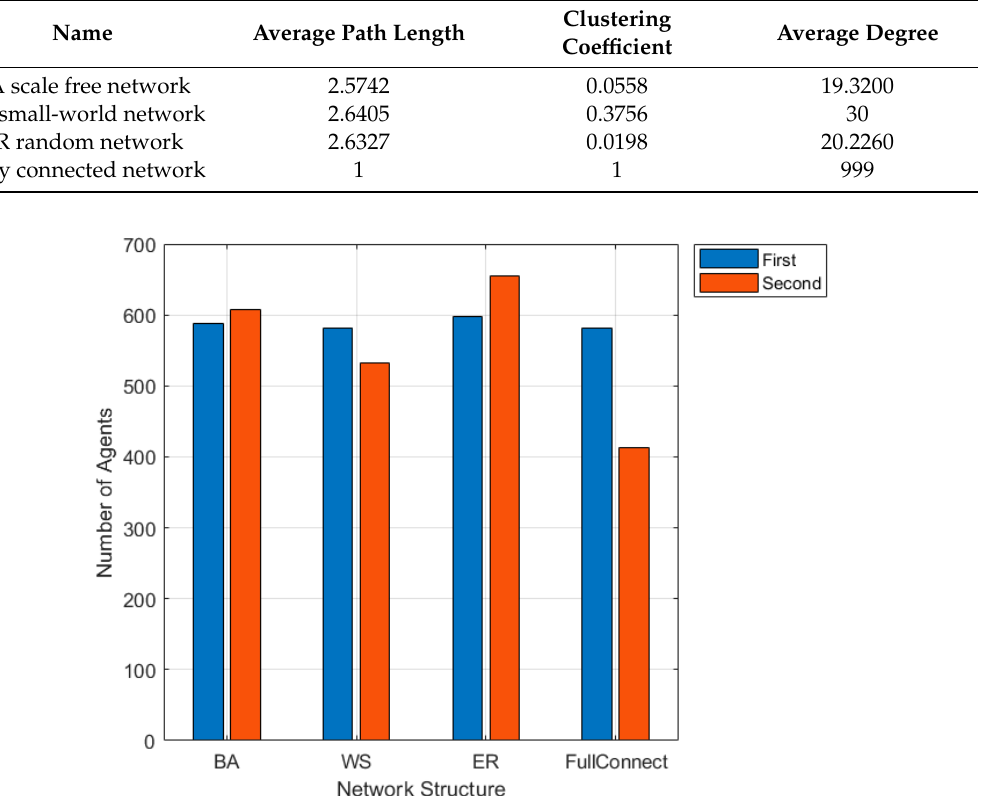
Figure 15. The changes of interactive nodes number under different network structure.